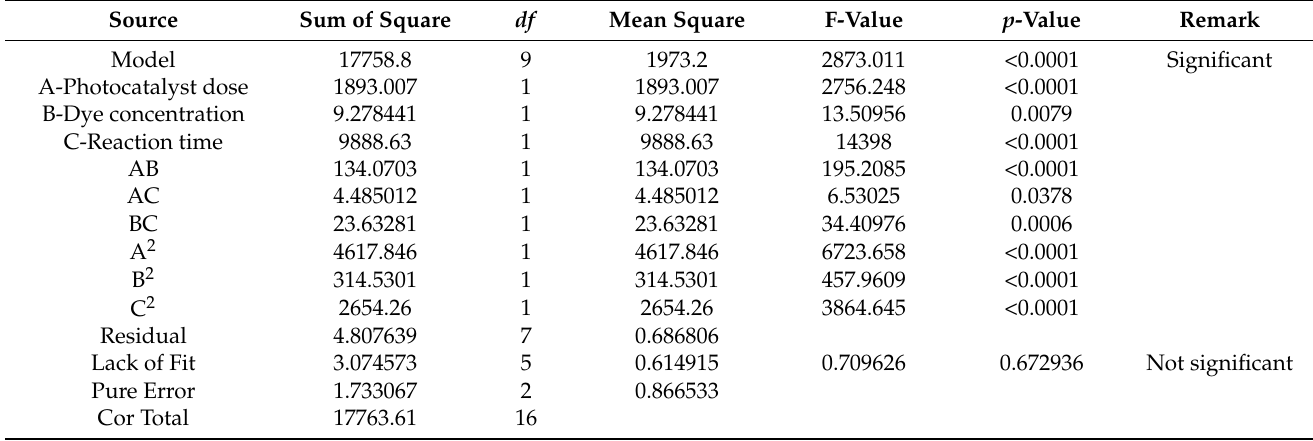
Table 4. ANOVA for photodegradation of RhB